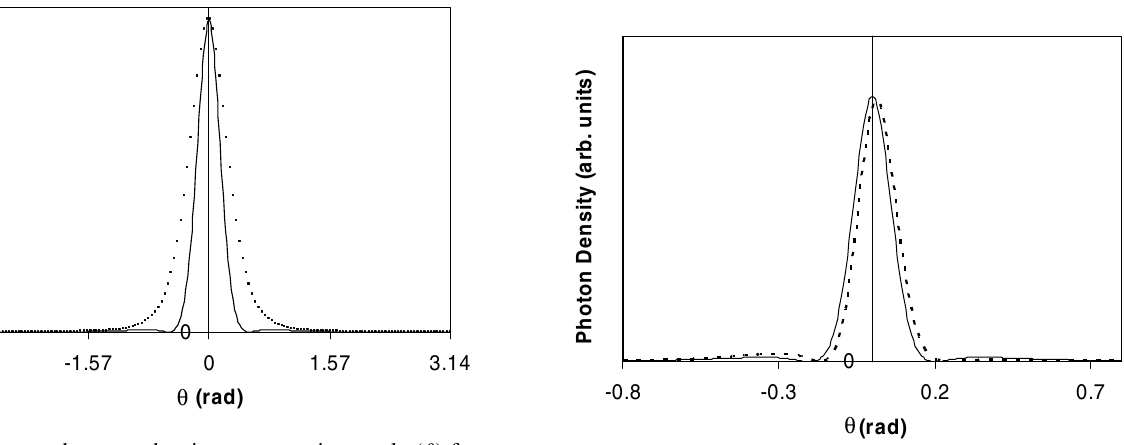
FIG. 6. Scattered photon density from a relativistic electron ( (cid:15) (cid:2) 5 ) in the x - z plane produced by an x polarized photon for the case of head-on interaction (solid line) and a side-on interaction (dotted line).